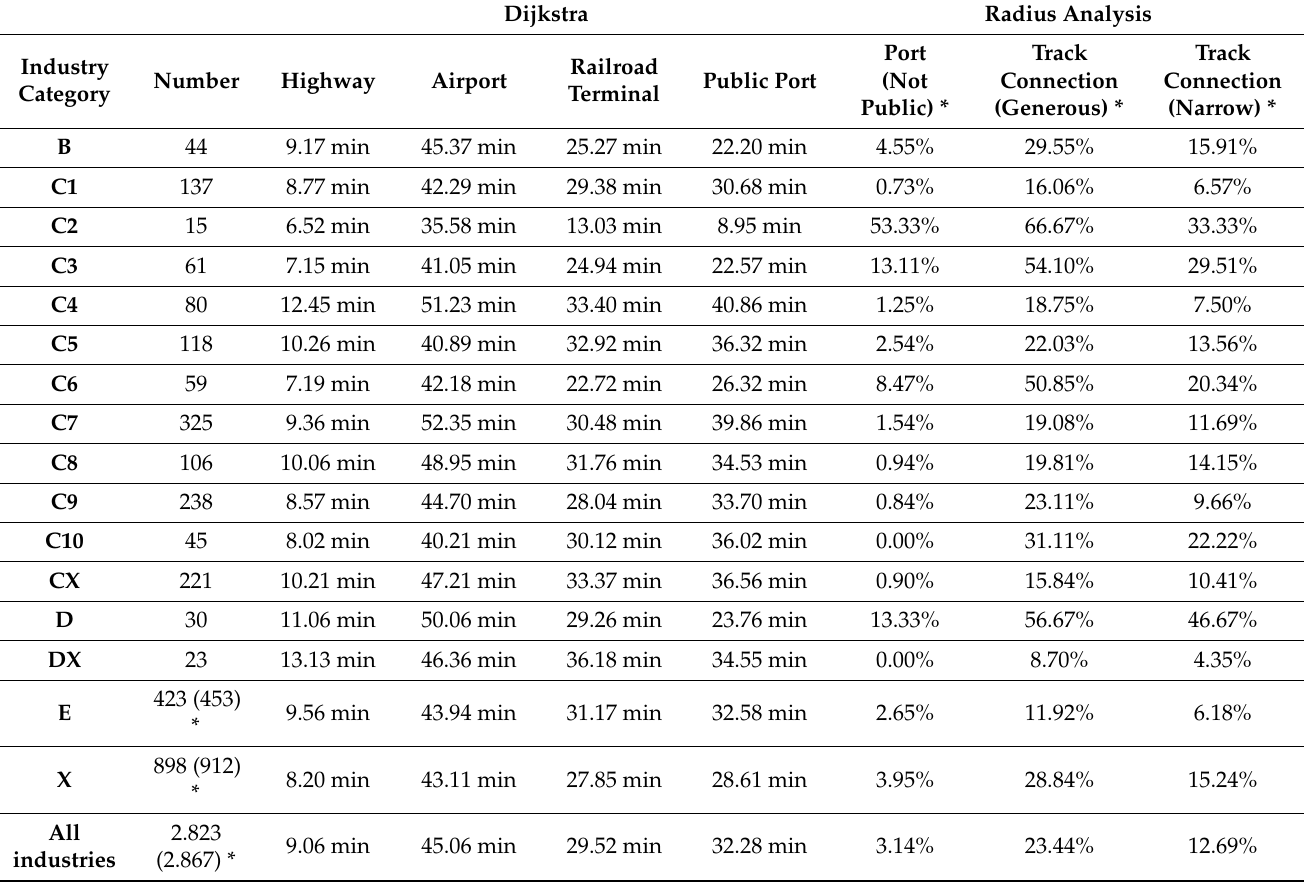
Table 3. Averages of travel times (Dijkstra) and share of allocations (Radius analysis) by industry category. * different numbers of industry E and X 2